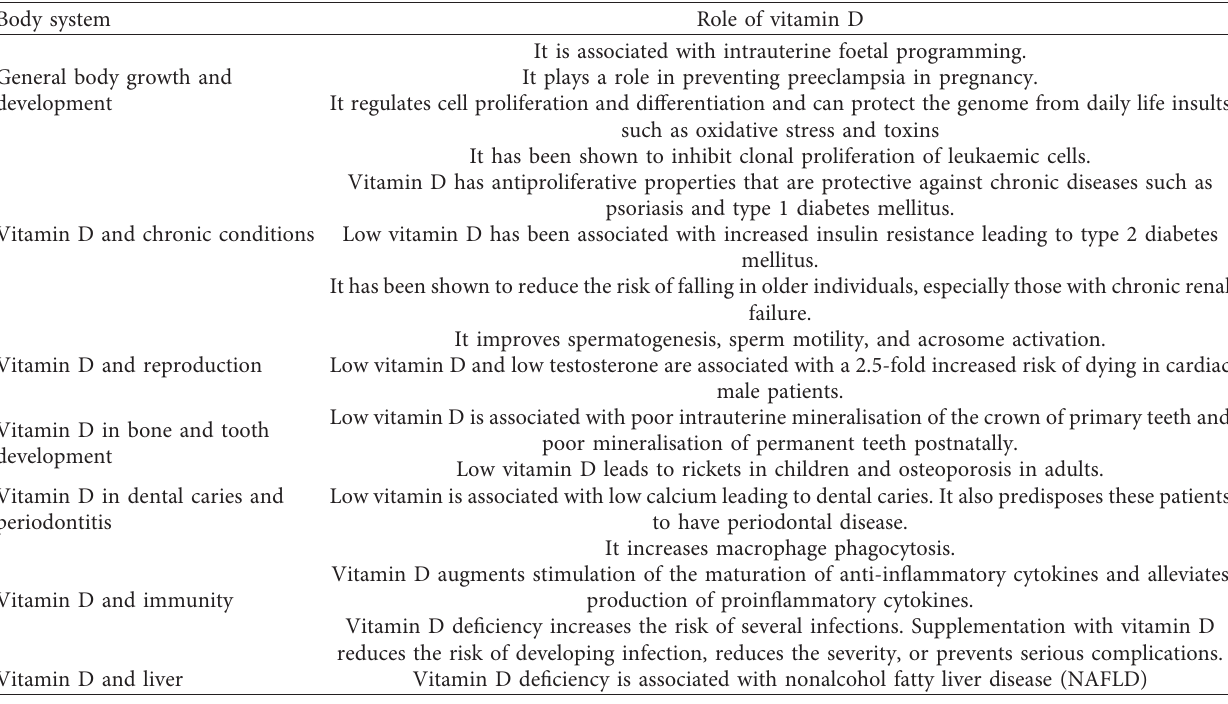
Table 1: The role of vitamin D in different body systems. Body system Role of vitamin